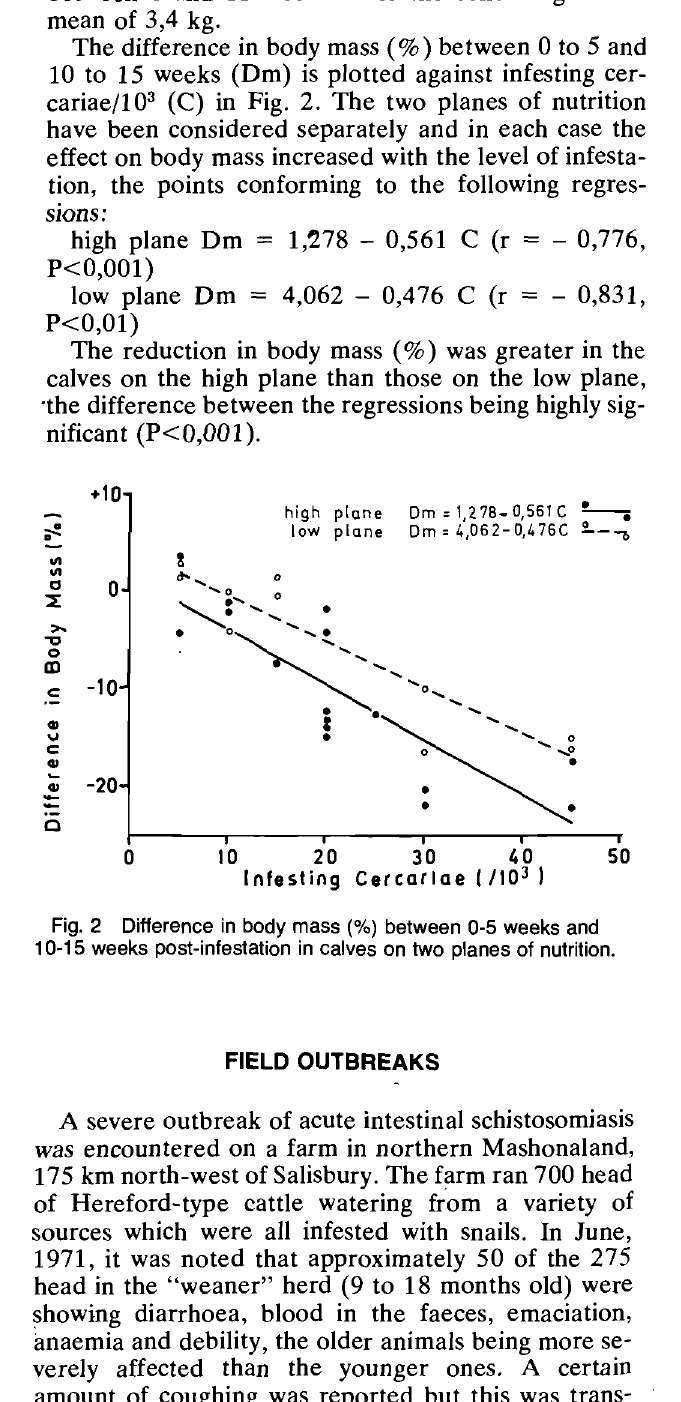
Fig. 1 Changes in mean body mass (%) in 10 calves.over 78 weeks after infestation.